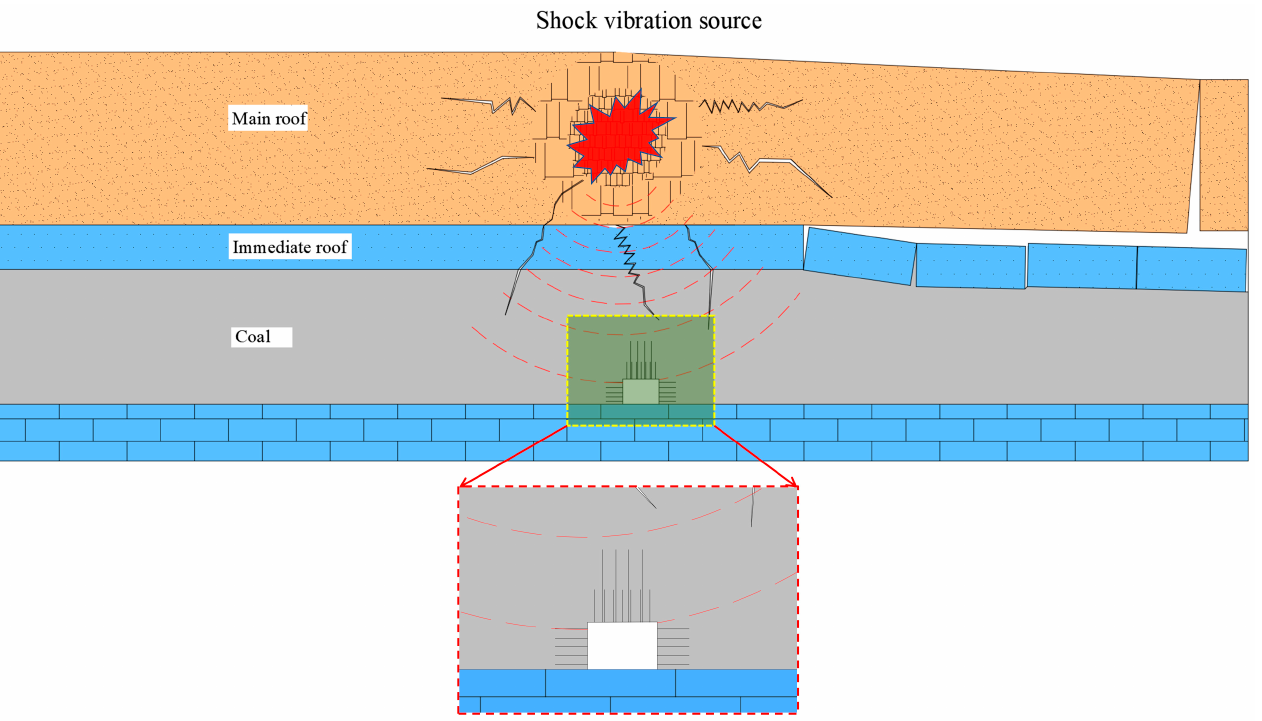
Figure 11. Mechanical modeling of shock wave a tt enuation through